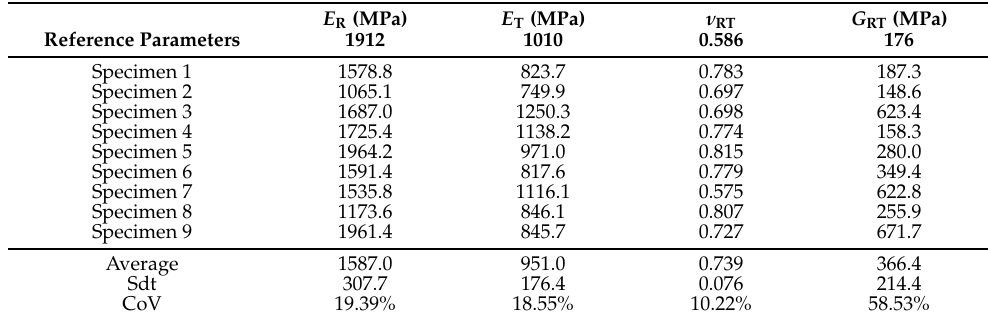
Figure 11. Experimental calibrated numerical and difference full-field strain maps for: ( a ) Specimen 1 and ( b ) Specimen 17. Table 8. Identified orthotropic linear elastic parameters for the on-axis specimens and comparison to the reference values [2,55].